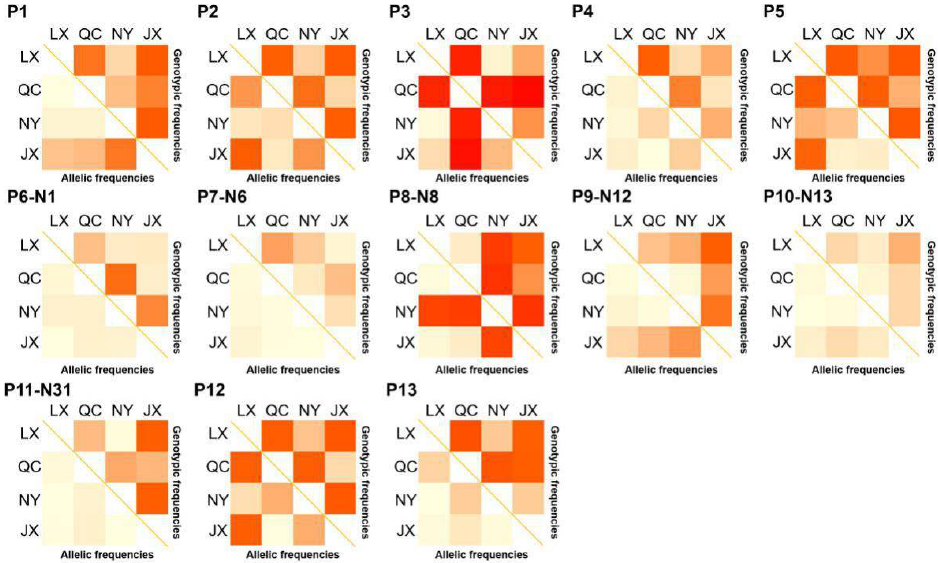
Figure 2. χ 2 test on genotypic and allele frequency distribution of variations in four Chinese cattle PSAP . QC: Qinchuan cattle; NY: Nanyang cattle; JX: Jiaxian red cattle; LX: Luxi cattle.